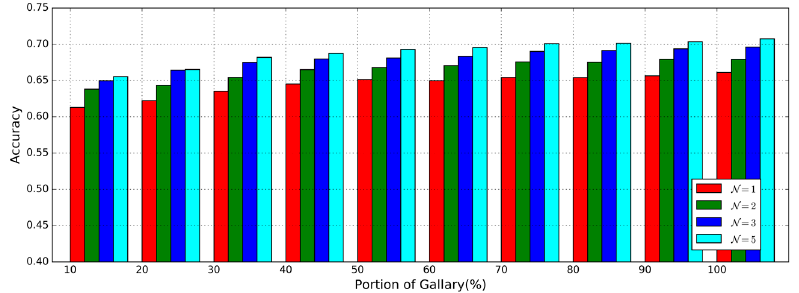
Figure 6. The accuracy of gait authentication on MCGILL dataset given the different proportion of gait patterns in the gallery.